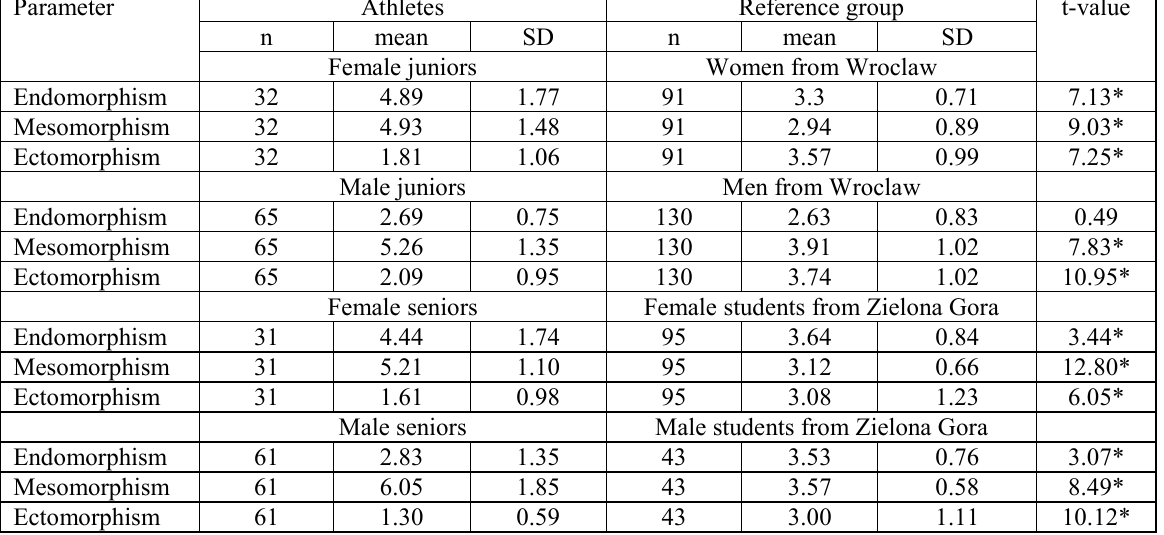
Type of body structure in female and male weightlifters depending on their biological age and in relation to non- training